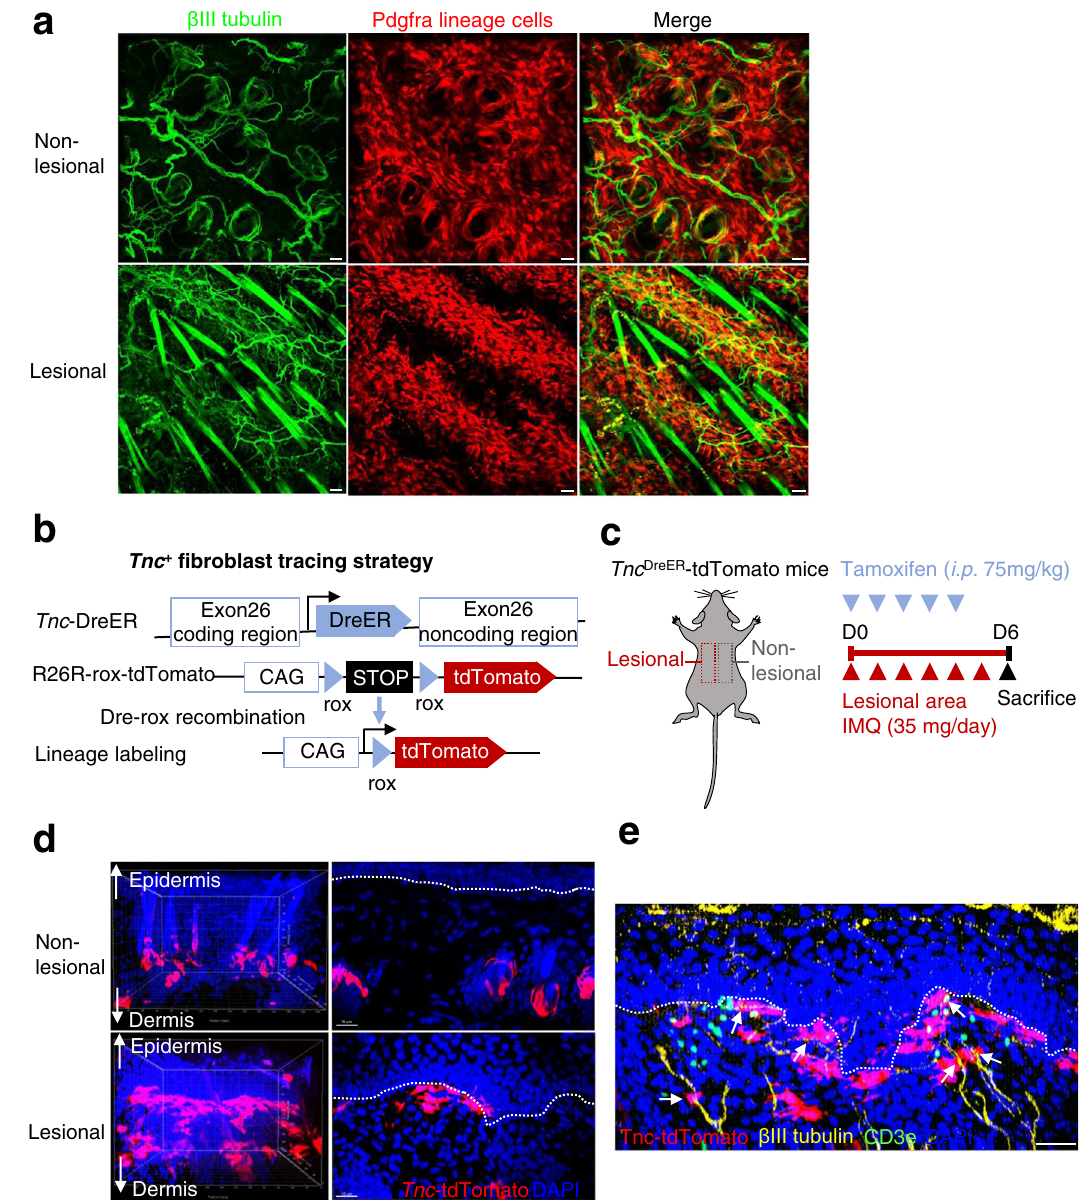
Fig. 3 | Papillary fi broblasts interacted with cutaneous nerves in the in fl amed skin.a Representativewhole-mountimagesofnon-lesionalorlesionalskinstained for β III tubulin (green) of IMQ-induced self-control Pdgfra DreER -tdTomato mice ( n =3).Scalebar,50 μ m. b Tracingstrategyof Tnc DreER -tdTomatomice. c Schematic diagram of IMQ-induced psoriasis mouse model in self-control Tnc DreER -tdTomato